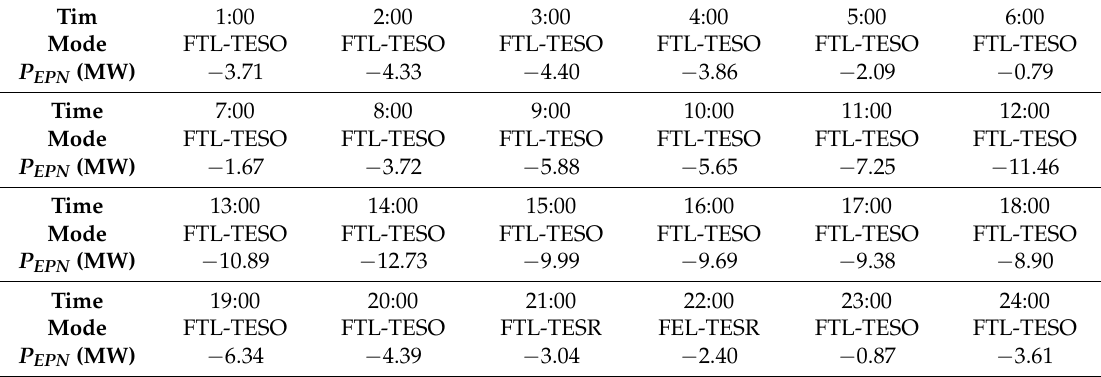
Figure 4. At 22:00, the under-pressure is gone, but overvoltage happens. So the operation mode is set as FEL-TESR (Thermal energy releasing rate is 3.95 MW). By introducing these two modes, the whole system operation is guaranteed to be normal. Table 6. CHP operation modes under the proposed control strategy in summer case ( C = 0.75).